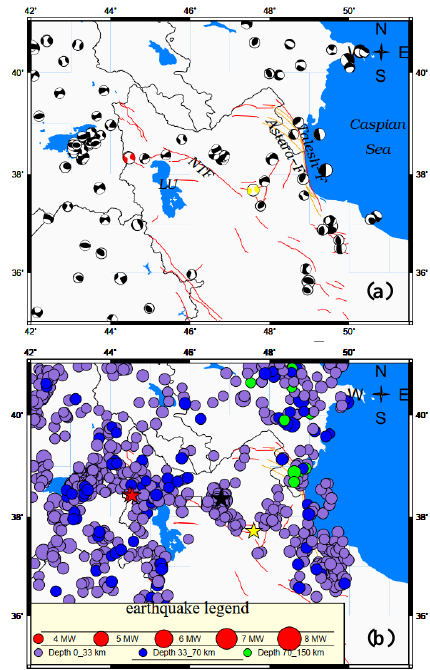
Figure 1. (a) Earthquake focal mechanism in the study area from 1980 to 2017 for M w ≥ 4. (b) Epicenter earthquake location in NW Iran from 1980 to